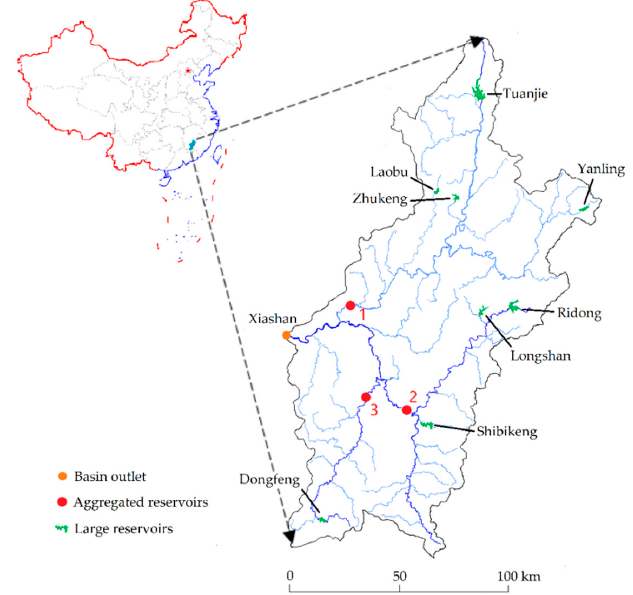
Figure 3. The upper Gan River basin. Eight large reservoirs are marked in green. Three red round markers with number 1, 2, 3 indicate aggregated reservoirs, which divide the basin into three sub-